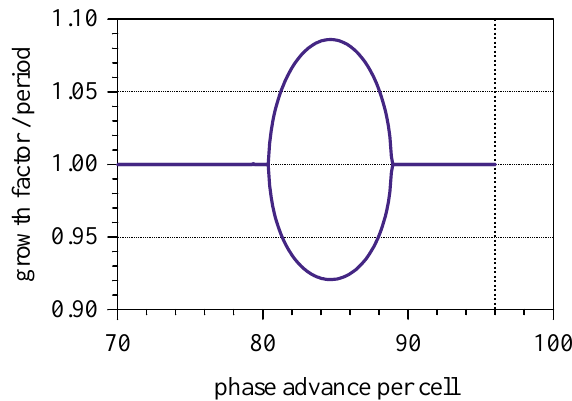
FIG. 13. (Color)Growth factors (per cell) for envelope instability of symmetric FODO cell with zero-current phase advance of s 0 (cid:1) 96 ± corresponding to n 0 x , y (cid:1) 6.4